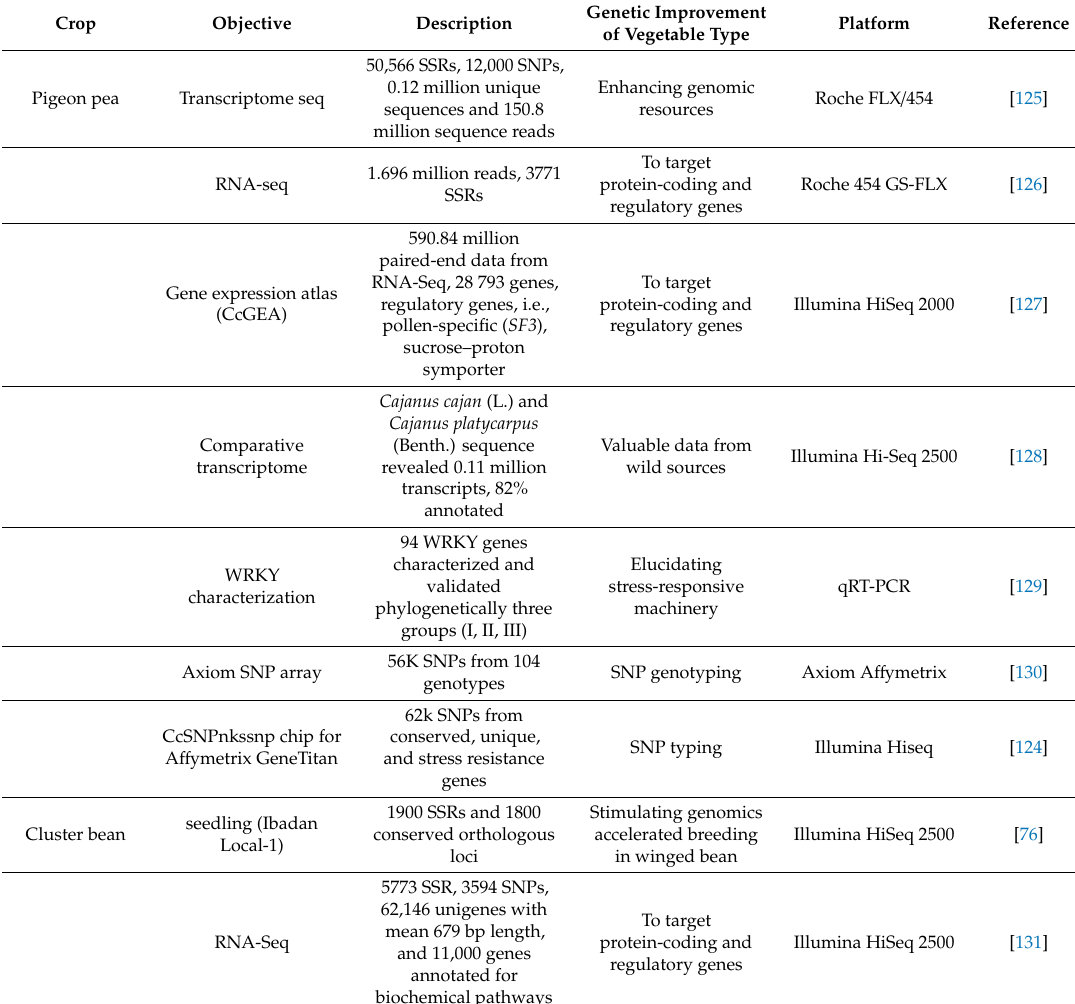
Table 2. Transcriptomic and valuable genomic resources in legumes (pigeon pea, cluster bean, winged bean, dolichos bean, and